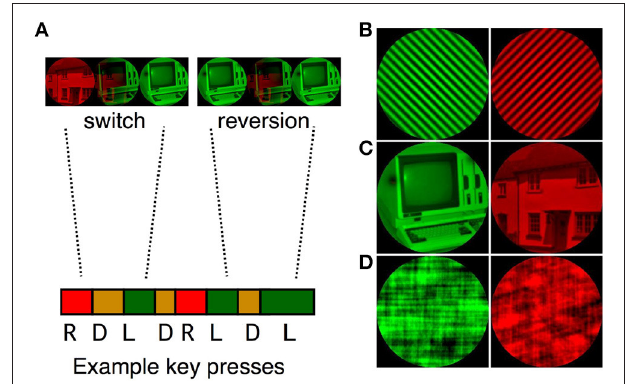
FIGURE 1 | (A) A sample sequence of binocular rivalry transitions. Participants were instructed to report red, mixed and green percepts by pressing the keyboard right, down and left arrows respectively. Transitions were classified as switches (e.g., R, D, L) or reversions (e.g., R, D, R). Examples of the simple grating (B) , complex object (C) , and scrambled object (D) pairs are presented on the right of the